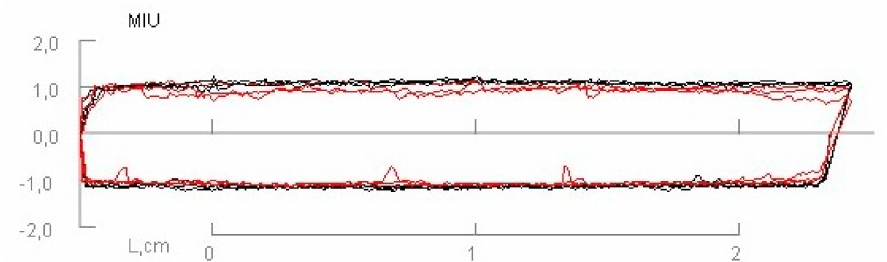
Figure 5. Coefficient of friction of polyurethane material without ultrasonic joint.